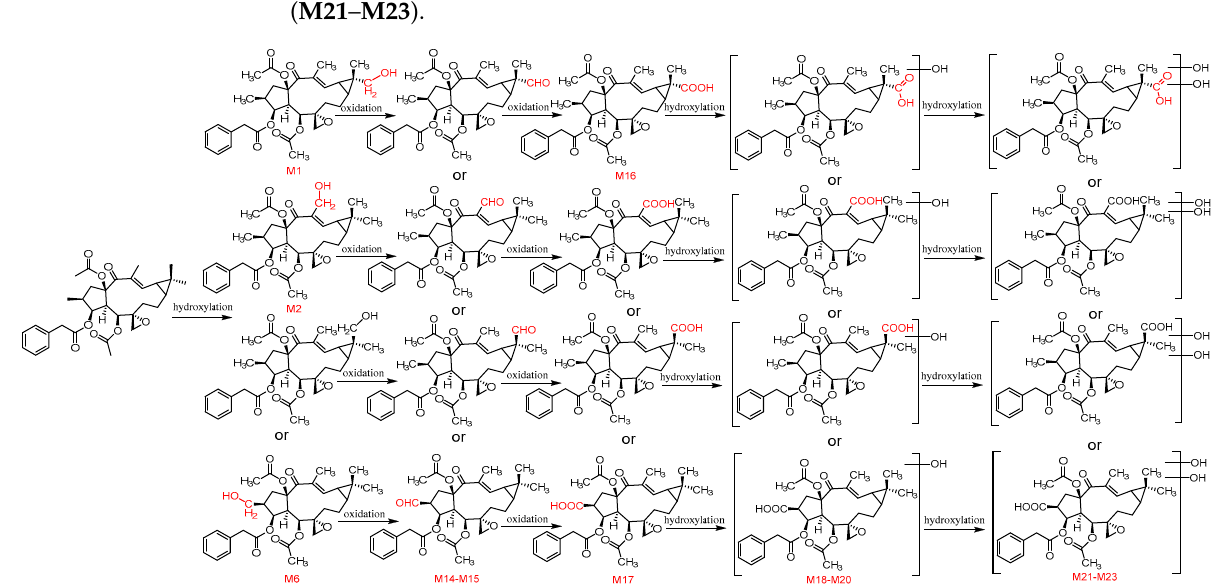
Figure 10. The proposed metabolic pathway of euphorbiasteroid in rats ( Ⅱ ). The third pathway involves hydrolysis of ester groups to form epoxylathyrol ( M24 ) and 15-deacetyl euphorbiasteroid ( M25 ), followed by hydroxylation to produce metabo- lites M26 – M27 , as shown in Figure 11.